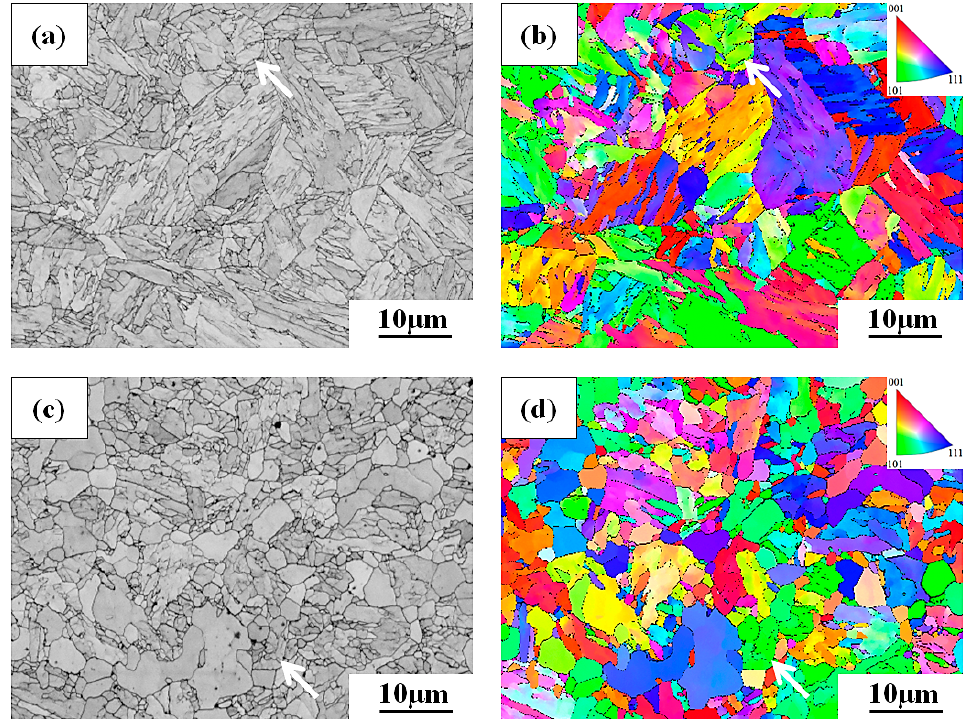
Figure 4. ( a ) SEM micrographs and ( b ) IPF map of the 1060NT-OT sample; ( c ) SEM micrographs and ( d ) IPF map of the 1060NT-PT sample.